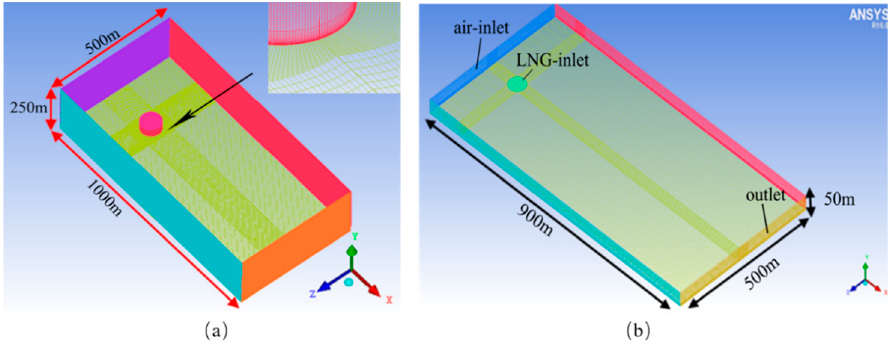
Figure 2. Mesh division in this study. ( a ) The meshing of the computational watershed; ( b ) the meshing of LNG leakage diffusion experiment.